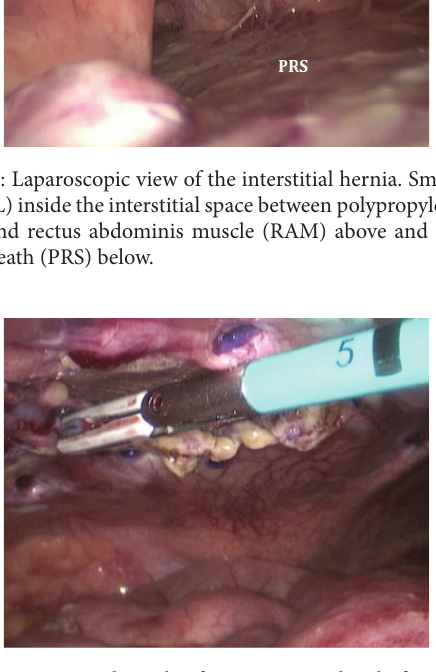
Figure 3: Uncovered mesh after posterior sheath fixation with absorbable tackers. The defects were